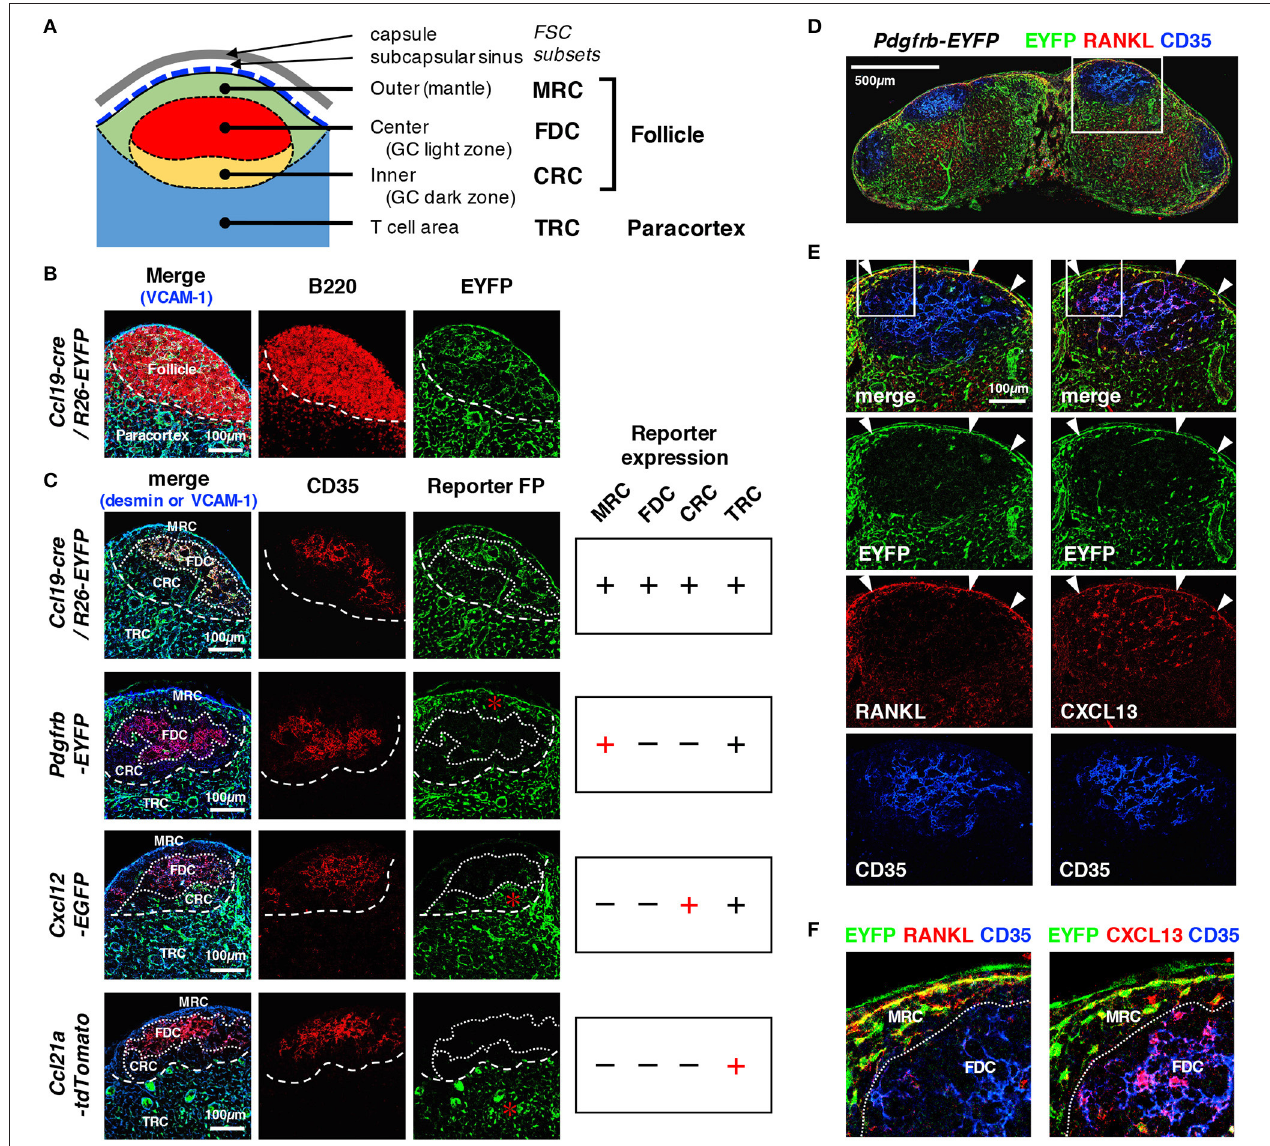
FIGURE 2 | Distinct patterns of reporter expression in cortical FSC subsets in mouse LNs. (A) Schematic representation of subcompartments and associated FSC subsets in the outer cortex. (B) Close-up view of the outer cortex. The border of the follicle and paracortex is indicated by the localization of B cells (dotted line). (C) The patterns of FP expression in reporter mice. CD35 expression is an indicator of the FDC network in the follicular center. Territorialities of the network of FSC subsets are indicated by dotted lines. FP expression in each FSC subset is summarized on the right. Asterisks indicate characteristic FP expression. (D–F) Expression of RANKL and CXCL13. Sections of an inguinal LN from Pdgfrb -EYFP mouse were stained for the indicated markers. The boxed regions in (D,E) are magnified in (E,F) , respectively. Note that MRCs express both RANKL and CXCL13 (arrowheads in E ), whereas FDCs express CXCL13 but not RANKL.